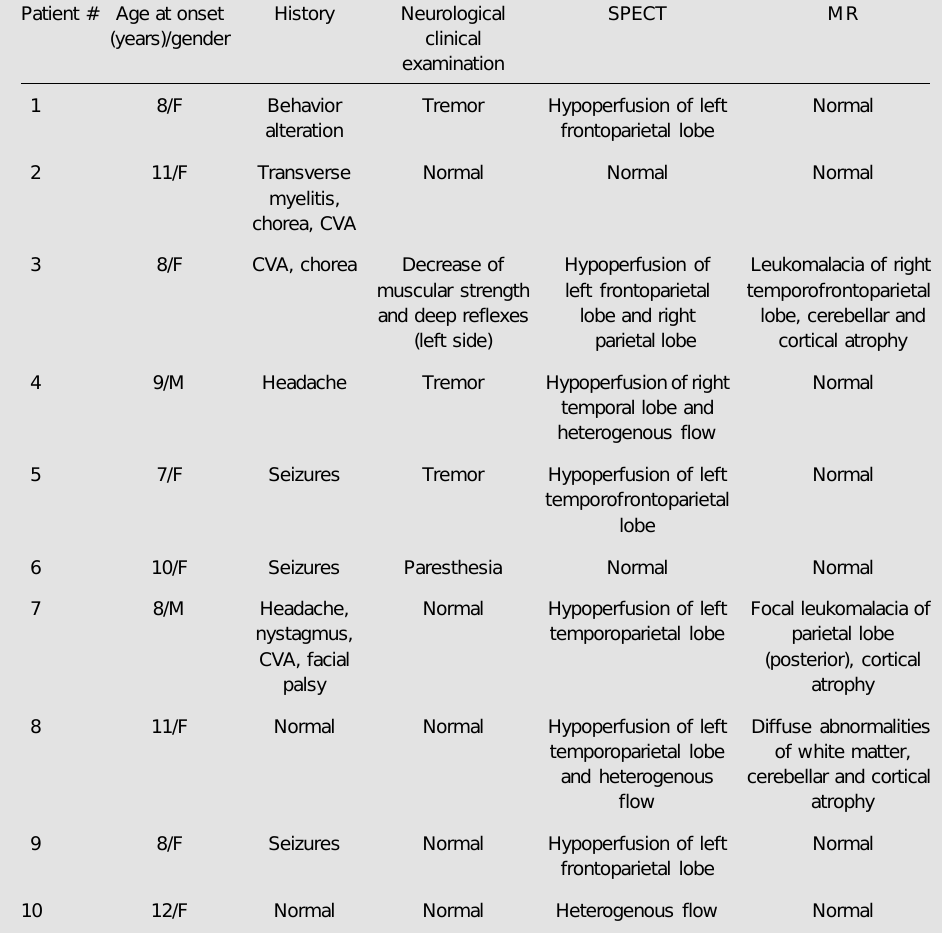
Table 1. Past and present neurological clinical history, neurological clinical examination, single photon emission computed tomography (SPECT) and magnetic resonance (MR) of JSLE patients who have pre- sented some degree of CNS involvement since the onset of the disease (N = 10).